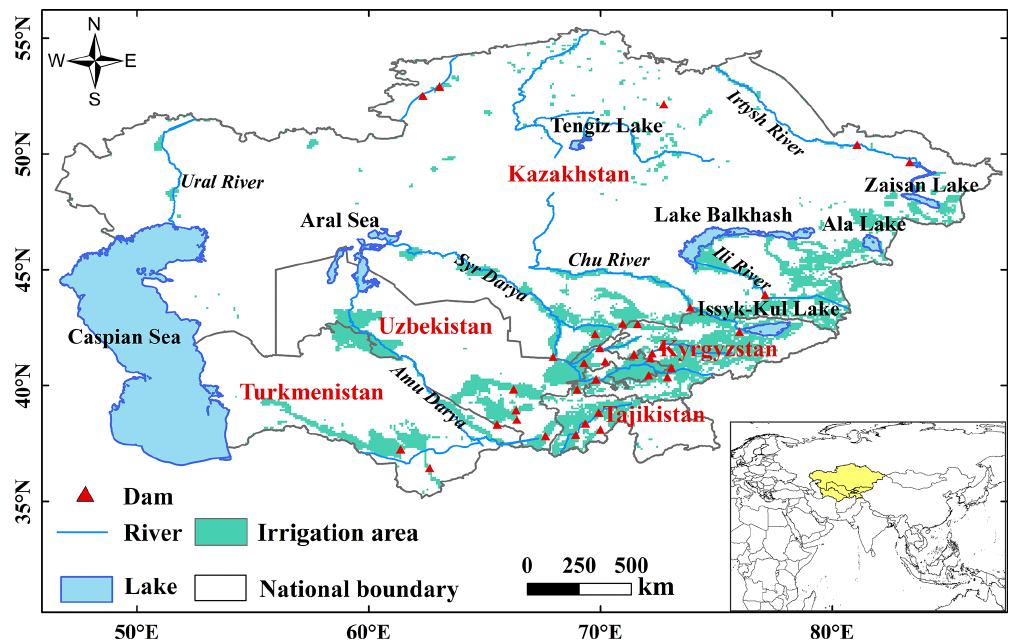
Figure 1. Location of Central Asia. This map is made with ArcGIS, and all layers are from the public layers. The world and country borders are from the National Platform for Common Geospatial Information Services (https://www.tianditu.gov.cn/, last access: 4 December 2020; GS(2016)2948), the lake outlines are from the Natural Earth Data (http://www.naturalearthdata.com/, last access: 4 December 2020), and the raster file of irrigation area is from the Food and Agriculture Organization of the United Nations (http://www.fao.org/aquastat/en/